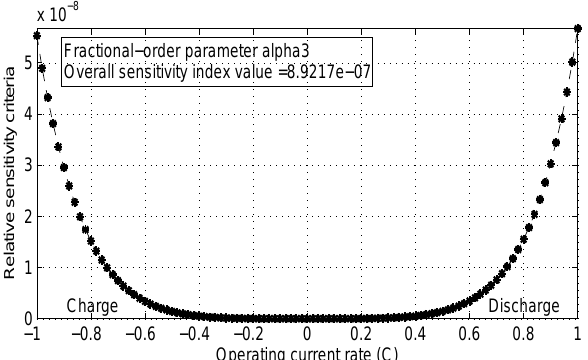
Figure 13. Sensitivity index values of insensitive parameter fractional-order factor α 3 at different operating current values.